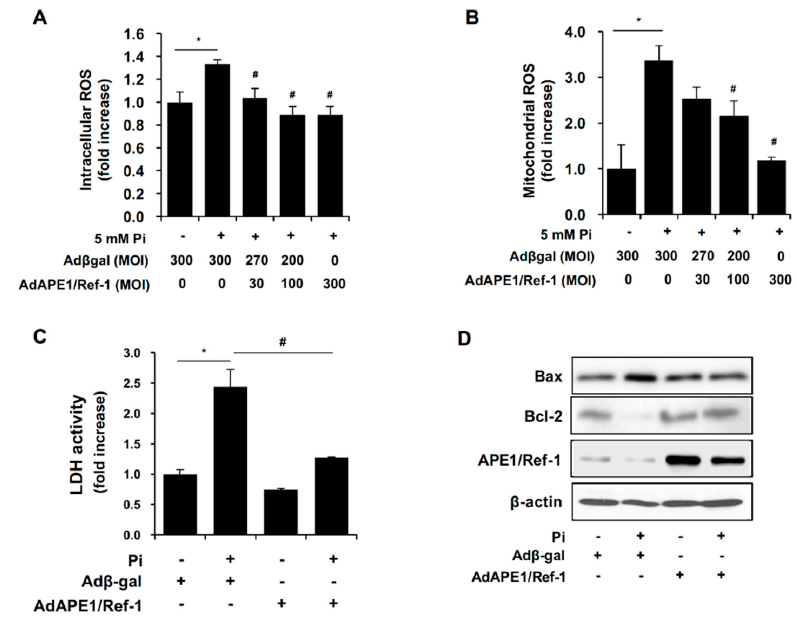
Figure 5. APE1/Ref-1 overexpression inhibits inorganic phosphate (Pi)-induced reactive oxygen species (ROS) production and apoptosis in vascular smooth muscle cells (VSMCs). ( A ) The level of